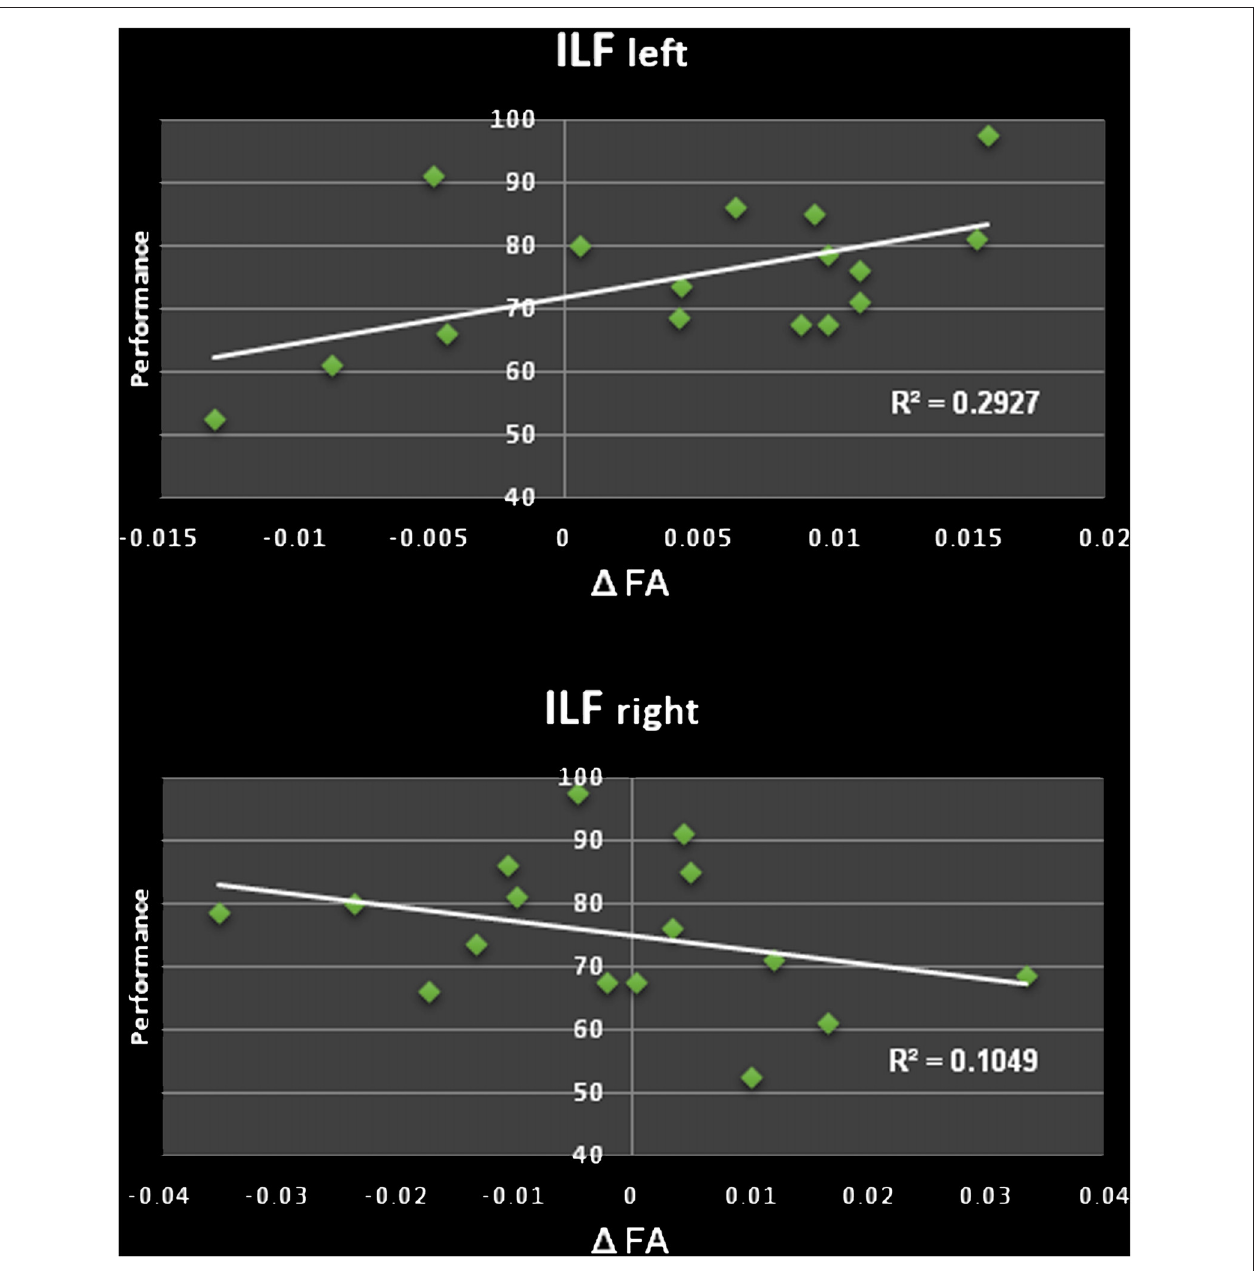
FIGURE 2 | Top: positive correlation of changes in the fractional anisotropy (FA; ∆ FA) in the left ILF and performance in the word/non-word discrimination task. Bottom: non-significant correlation of FA changes FA ( ∆ FA) in the right ILF and performance of the word/non-word discrimination task.